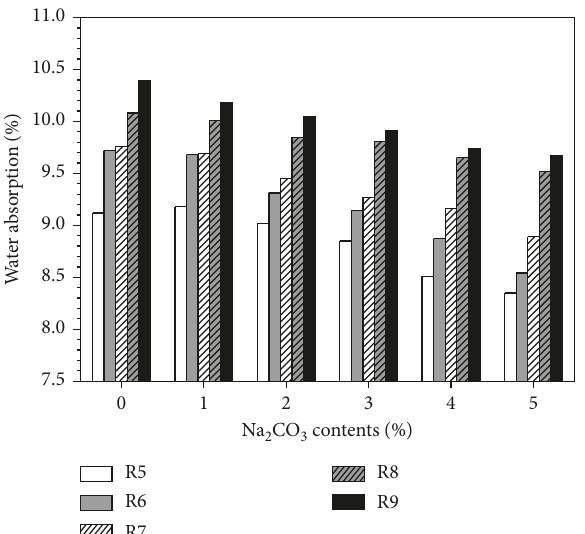
Figure 4: Water absorption of HVSC pastes containing Na